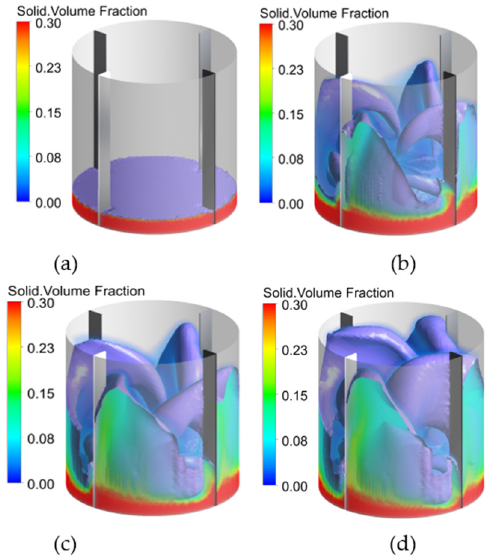
Figure 19. 3D solid volume fraction contour plots and cloud height for different impeller speeds. ( a ) 180 rpm, ( b ) 300 rpm, ( c ) 420 rpm, ( d ) 540 rpm.